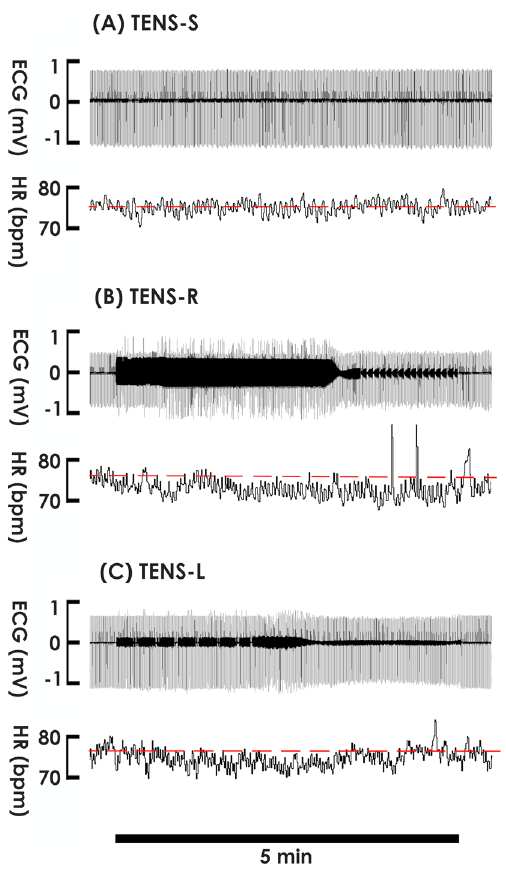
Figure 2. Electrocardiogram (ECG) and heart rate (HR) of subjects in response to ( A ) sham stimulation (TENS-S) and ( B , C ) TENS on the right and left shoulder (TENS-R and TENS-L, respectively) for 5 min. The black bar at the bottom indicates the stimulation